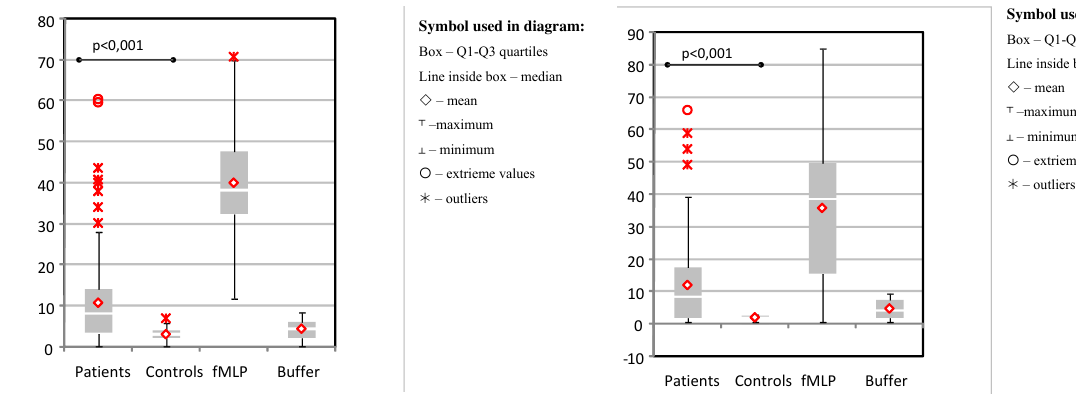
Figure 3. CD63 expression (%) in patients (n=128) vs healthy Figure 4. CD203c expression (%) in patients (n=128) vs healthy controls (n=30), positive (fMLP) and negative (buffer) controls (n=30), positive (fMLP) and negative (buffer) Figure 3. CD(cid:25)3 expression (%) in patients (n=128) vs healthy controls (n=30), positive (fMLP) and control results on donor basophils. control results on donor Figure 4. CD203c expression (%) in patients (n=128) vs healthy controls (n=30), positive negative (buffer) control results on donor basophils (fMLP) and negative (buffer) control results on donor basophils